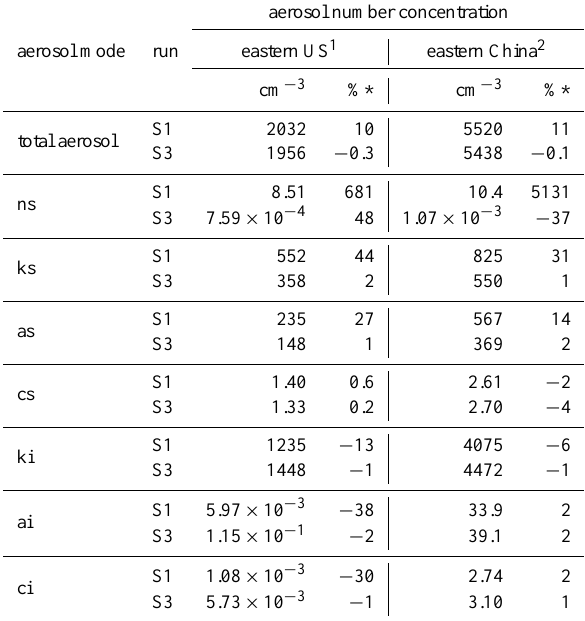
ulated mean aerosol number concentrations and their relative en- hancement as a result of simulating realistic HONO levels during